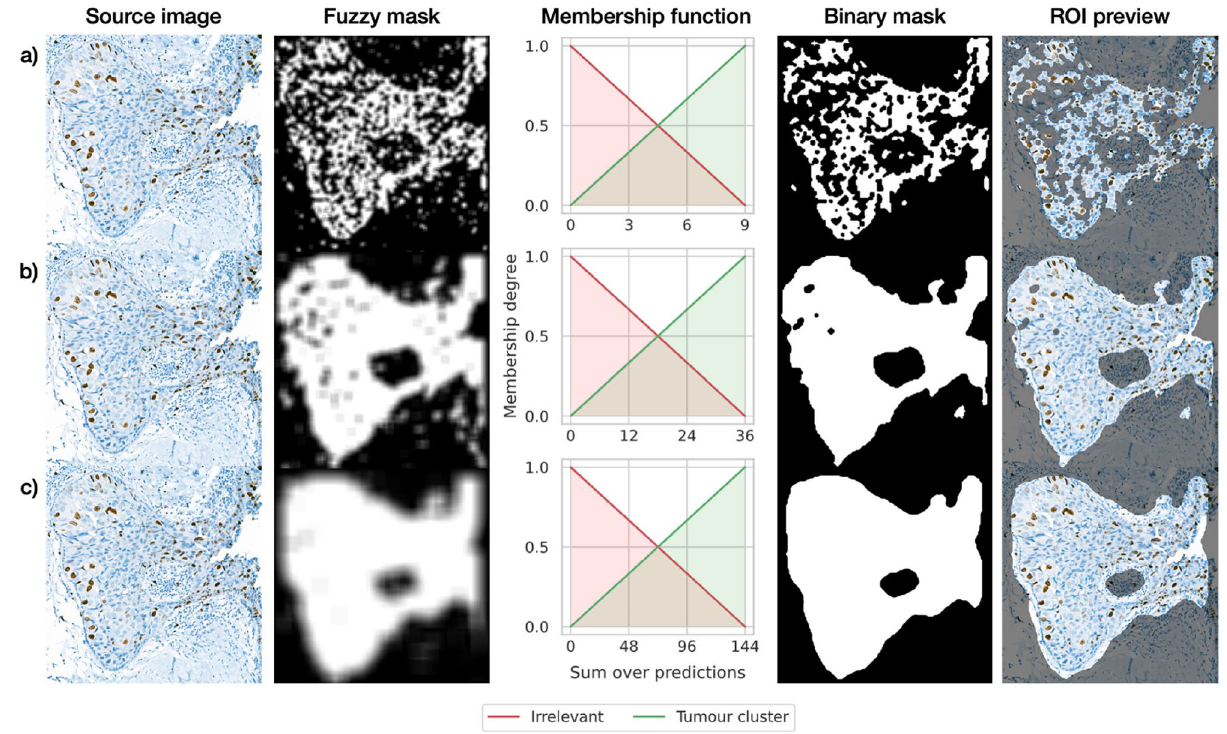
Figure 3. The complete defuzzification process for ( a ) 48-, ( b ) 96-, ( c ) 192-pixels window size applied in the neural network